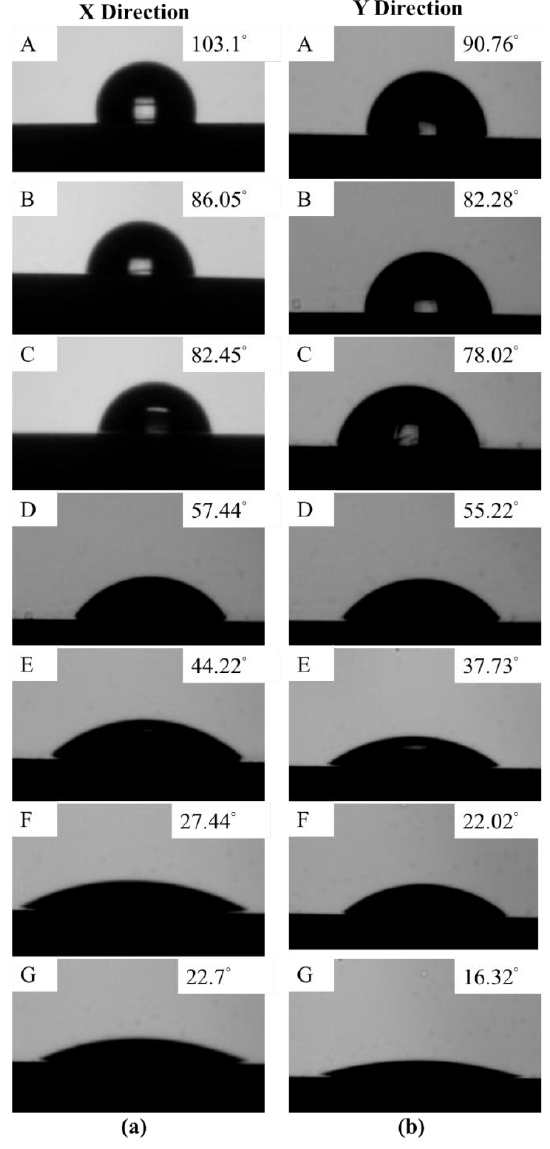
Figure 5. Contact angles images of the present specimen A – G with ( a ) X direction and ( b ) Y direction, and they have consistent variety among specimens A – G. (Specimen A — electropolished for 300 s, Specimen B — electropolished for 200 s, Specimen C — electropolished for 100 s, Specimen D — chemically polished for 2 min, Specimen E-mechanically polished by #1500 SiC, Specimen F — mechanically polished by #1000 SiC, and Specimen G-obtained after CNC cutting of pristine material).